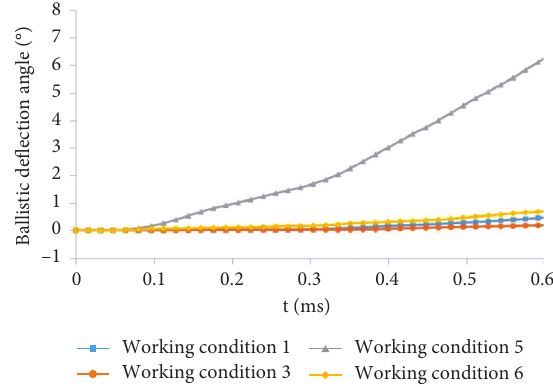
Figure 8: Ballistic offset angle change of the missile